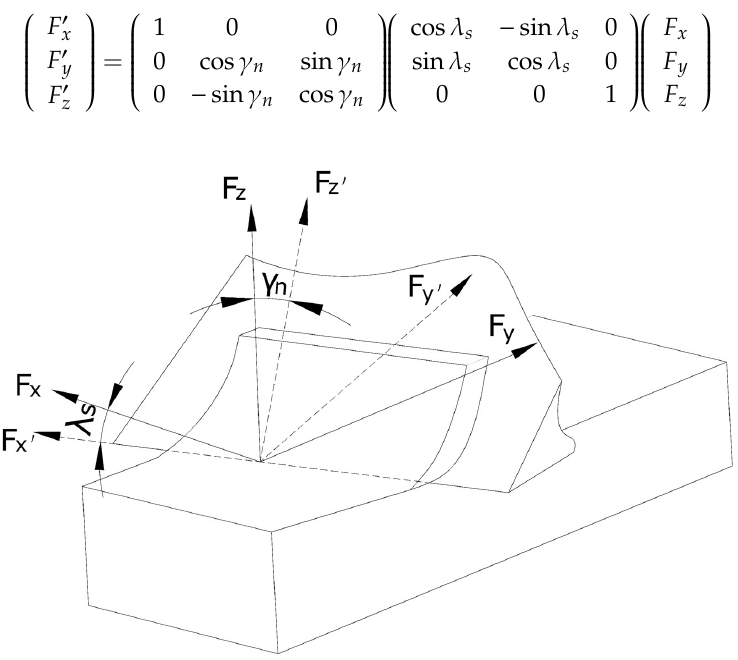
Figure 5. Conversion model of bevel cutting and right angle cutting.